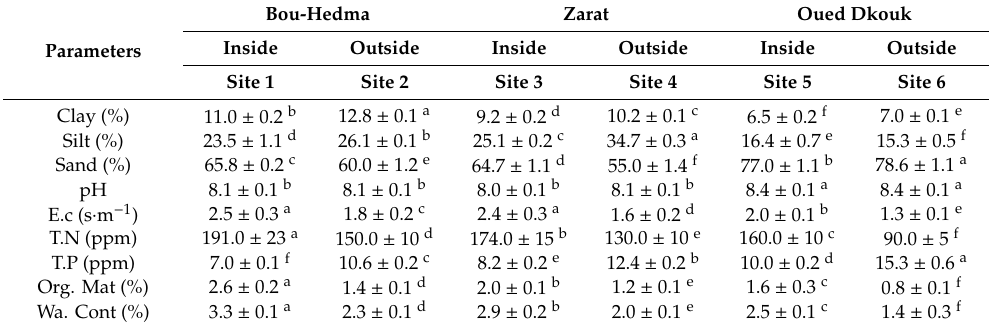
Table 2. Physical and chemical properties of the six sampling sites from the three conserved ecosystems.